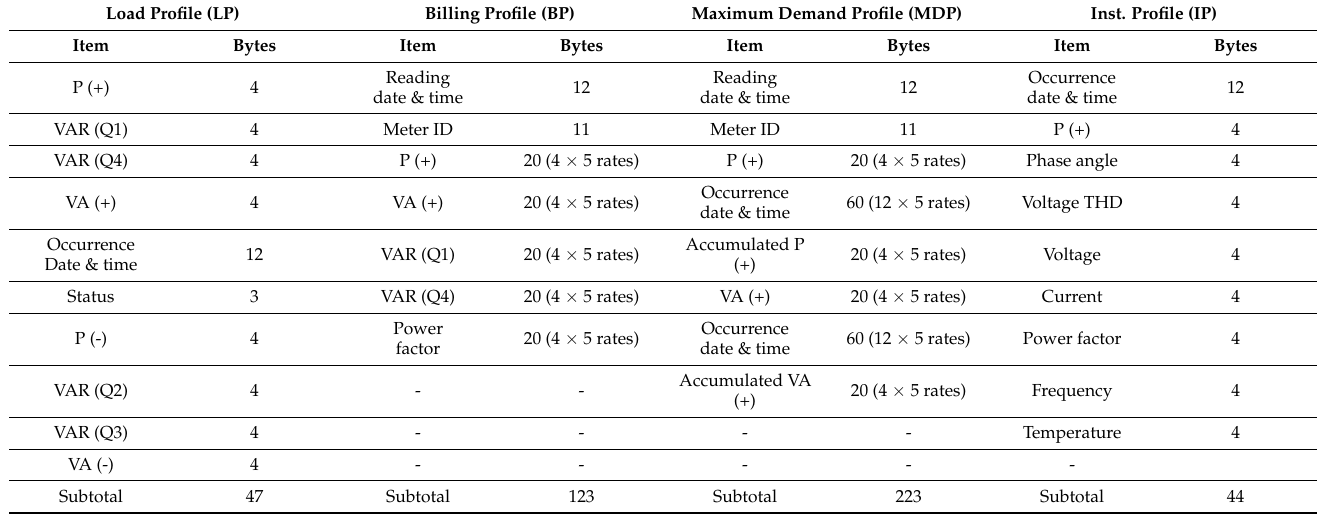
Table 6. KEPCO metering profile items used in the analysis.